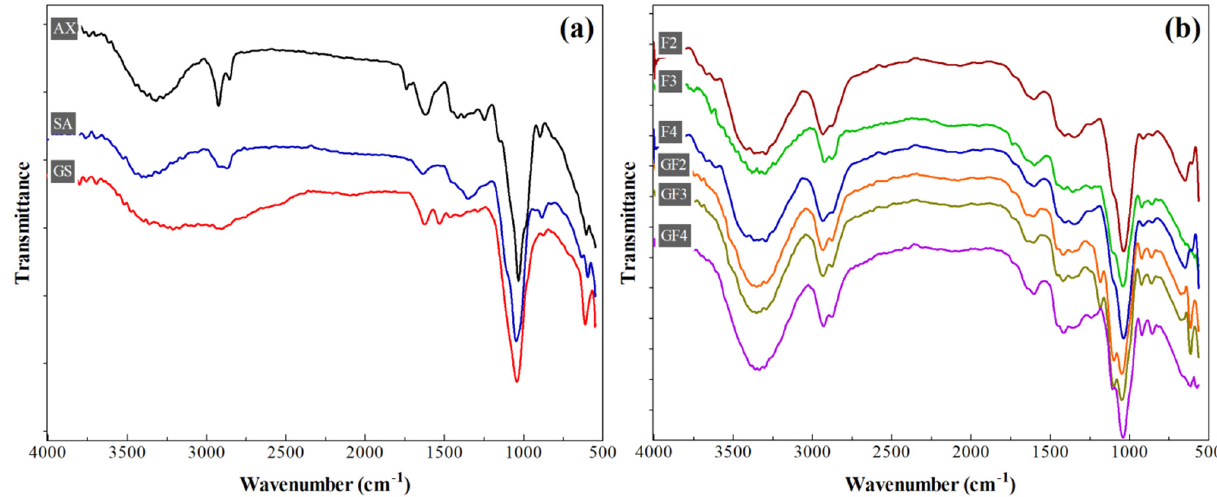
Figure 3. ATR-FTIR spectra of ( a ) pure components and ( b ) AXSA films.